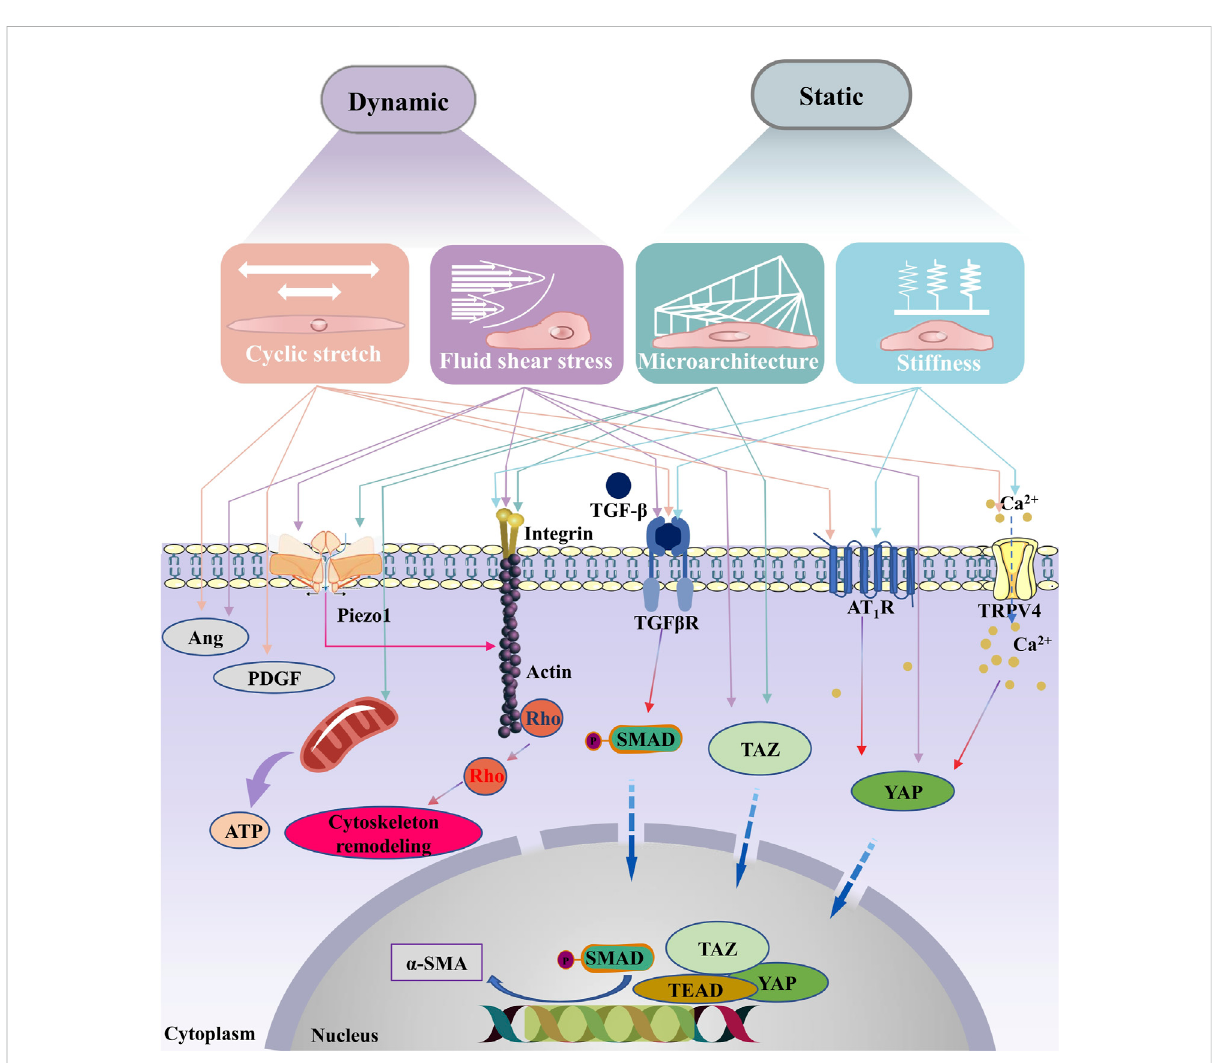
FIGURE 2 Signaling pathways associated with the biomechanical traits of cardiac fi brosis. With the changes of ECM mechanical properties during the process of cardiac fi brosis, myo fi broblasts are activated . In classical signaling pathway, the TGF- β receptor ’ s activation induces phosphorylation of the C-terminus of SMAD. The phosphorylated SMADs then form a complex with the co-mediator SMAD, SMAD4, the complex is translocated into the nucleus, where it binds to the gene promoter. Upon myo fi broblasts are activated, TGF- β is released from binding proteins in the ECM, leading to sustained activation and contraction of myo fi broblasts, fi nally causing a vicious cycle of fi brotic progression. In addition, integrins which sensechangesinexternalforcescanalsocontributetotheremodelingofthecytoskeleton.Studieshaveshownthattheactivation ofcellmembrane surfacemechanosensitivereceptors(suchasPiezo1,AT 1 RandTRPV4)arealsokeypathwaysintheviciouscycleof fi brosis.Correlationalstudieshave shown that Piezo1 can be activated by shear stress, stretching and matrix microarchitecture. Ang, Angiopoietin; TGF- β , transforming growth factor- beta; PDGF, plateau-derived growth factor; α -SMA, Piezo1, piezo type mechanosensitive ion channel component 1; alpha-smooth muscle actin; TGF β R, transforming growth factor-beta receptor; TRPV4, transient receptor potential vanilloid type 4; YAP, YES-related proteins;